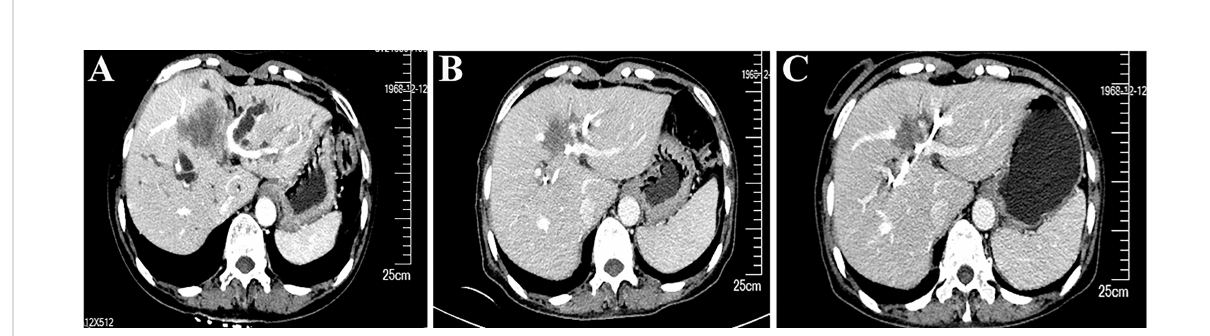
FIGURE 2 Cytologic examination and hematoxylin-eosin (HE) staining of liver tumor tissue from the needle biopsy and resected specimen. (A) Cytologic examination shows the presence of cancer cells (1000×). (B) HE staining (200×) of the liver tumor tissue from the needle biopsy. (C) HE staining (100×) shows only necrotic tissue in the resected